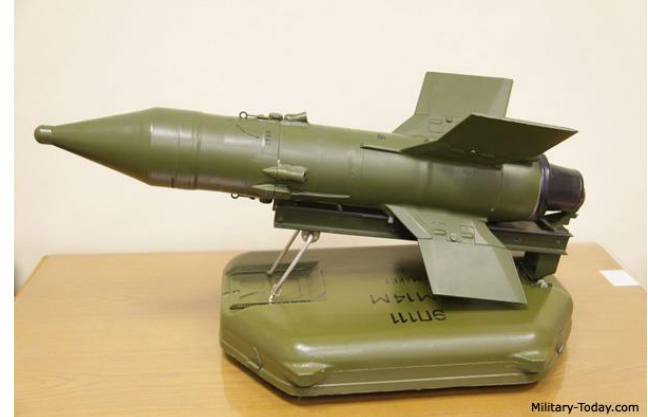
Figure 1 – 9M14 Malyutka (AT-3 Sagger), (Military-Today, 2021) Рис. 1 – 9M14 «Малютка» (Military -Today, 2021) Слика 1 – 9M14 „Маљутка ” (Military -Today,